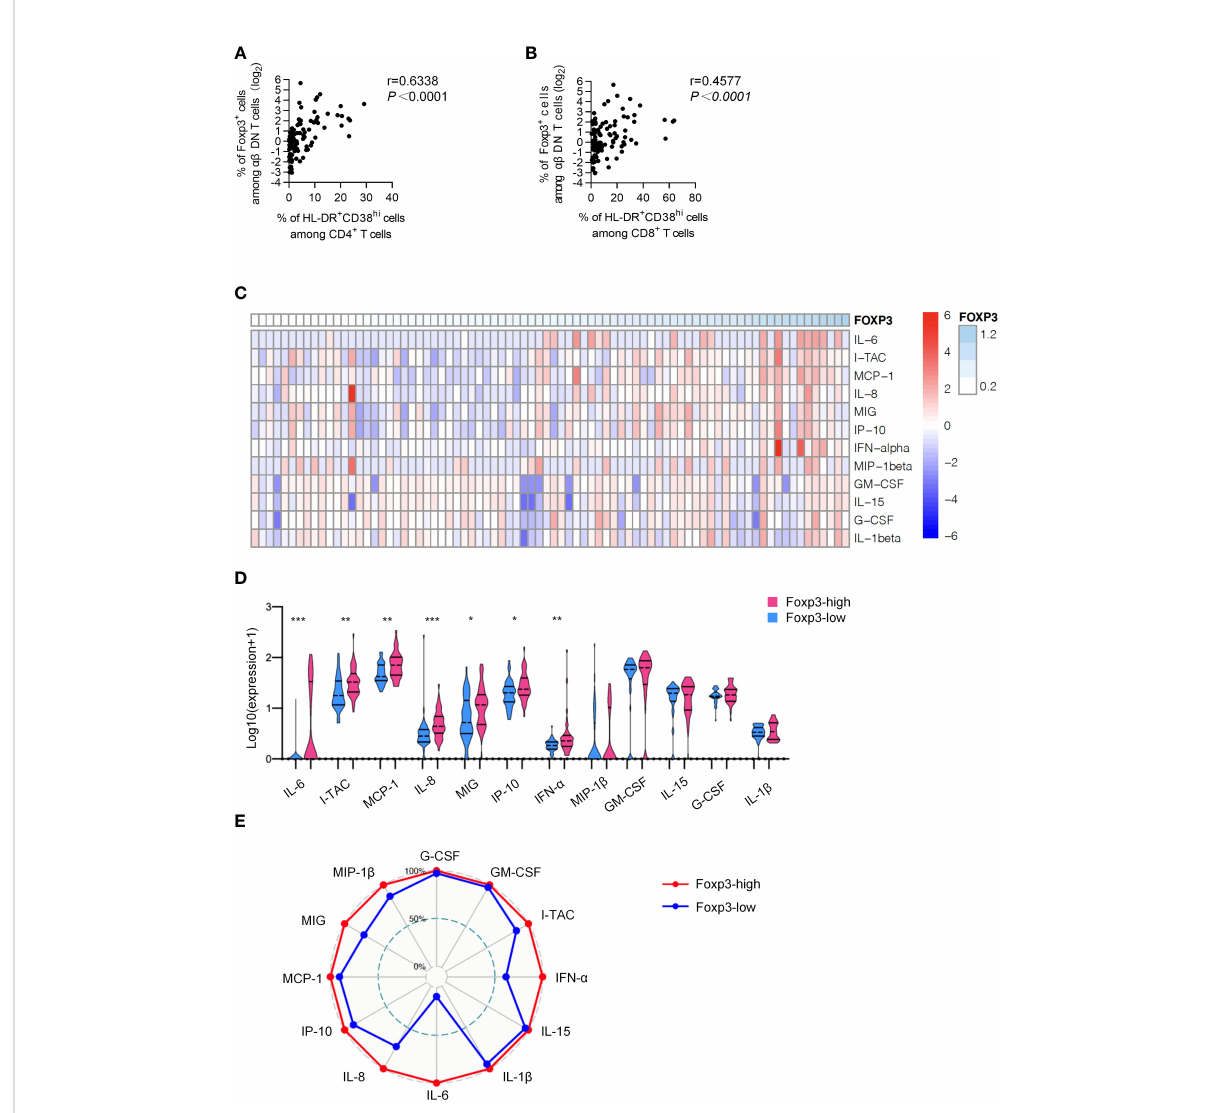
FIGURE 2 Foxp 3+ DNT cells correlated with the phenotypic pro fi le of activation and systematic in fl ammation. (A, B) Correlation analysis between the percentage of Foxp3 + DNT cells and (HLA-DR + CD38 hi CD4 + T cells (A) and HLA-DR + CD38 hi CD8 + T cells (B) from TNs. Spearman ’ s non- parametric test was used to test for correlations. (C) Heatmap depicting the relative concentrations of 12 differentially expressed serum proteins in TNs. Each column of the heatmap indicated a sample, while the rows represented different serum proteins. The color scale in the heatmap represented scores standardized across rows.(blue represented low levels; red, high levels) (D) Violin plots of the concentration of twelve differentially expressed serum proteins in the Foxp3-low group (n = 40) and Foxp3-high group (n = 40). The concentration of different serum was shown on a log10 scale. P values were obtained by Kruskal-Wallis test followed by Dunn ’ s multiple comparisons test. (E) Radar map of 12 differentially expressed serum proteins in Foxp3-low group (n = 40) and Foxp3-high group (n = 40). The radius is the percentage of expression. * P < 0.05, ** P < 0.01, *** P <